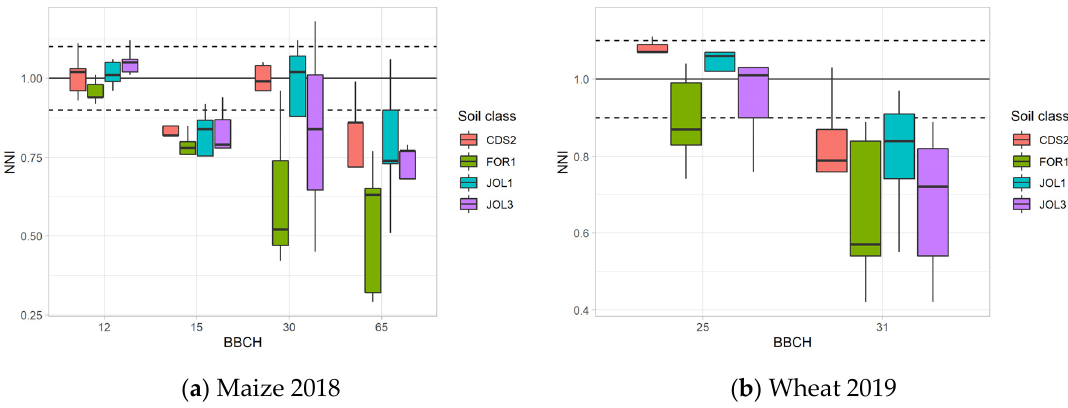
Figure 5. Boxplot of Nitrogen Nutrition Index (NNI) values during different phenological phases according to soil classes identified in Table 5. All 5 N treatments are included in each boxplot. Dot lines at NNI of 0.9 and 1.1 represent good nutritional conditions of the crop.